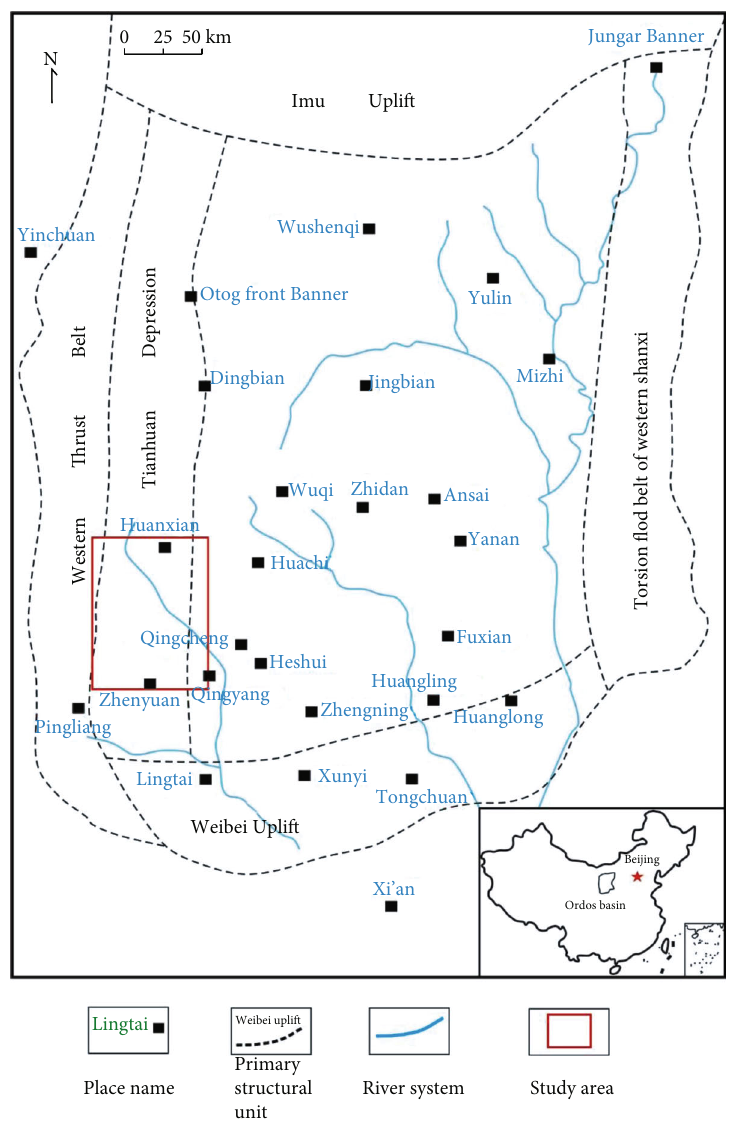
Figure 1: Geological map of the Pengyang area, Ordos Basin,